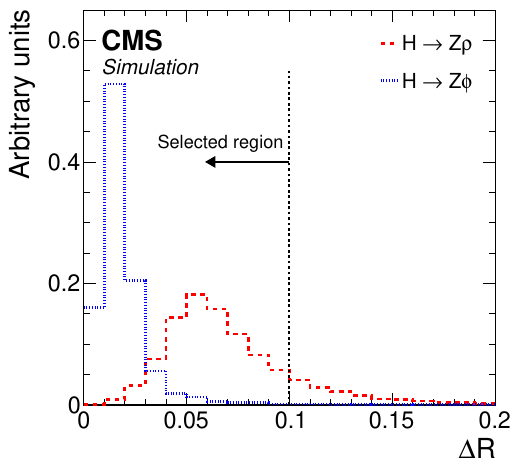
Figure 2 . The angular distance ∆ R between the two tracks from the meson decay in H → Z (cid:26) events (dashed red) and in H → Z (cid:30) events (dotted blue). The separation is calculated between reconstructed tracks that are matched to the generator-level pions (kaons) to ensure that the tracks originate from the (cid:26) ( (cid:30) ) decay. Both contributions are normalized to the same area.